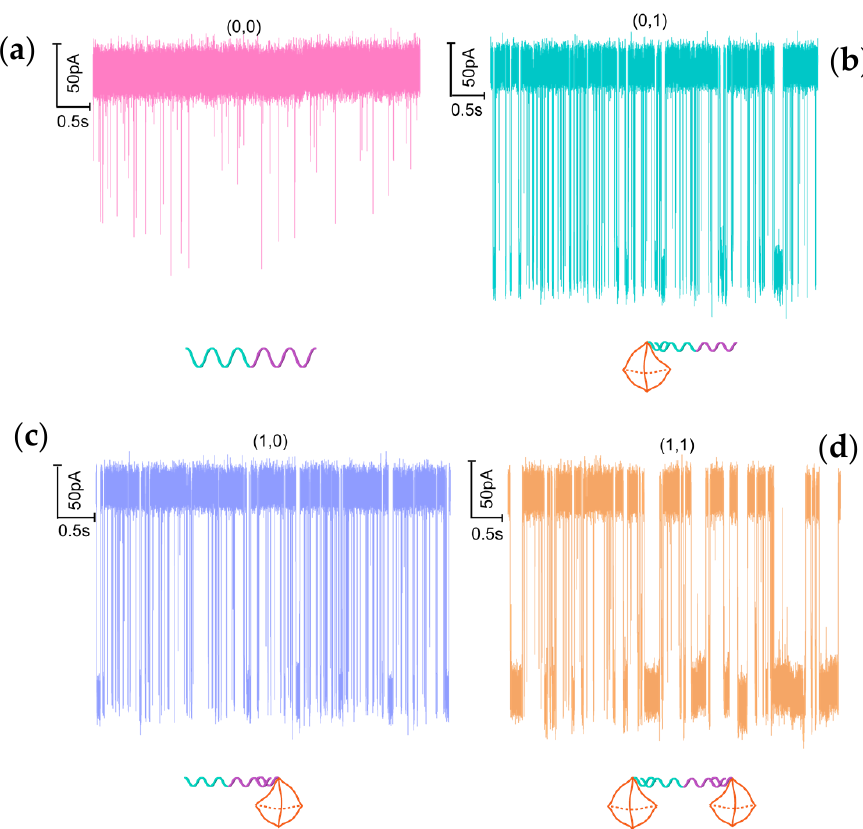
Figure 2. ( a – d ) Continuous current traces for different DNA logic operations (0, 0), (0, 1), (1, 0), (1, 1) translocation through a 3.5 nm diameter solid-state nanopore under 100 mV voltage in 1 M LiCl. The concentrations of tetrahedron Probe 1 and Probe 2 were 10 nM, respectively. The molar ratios of Probe 1/Probe 2/DNA(miR-21) are 0:0:1 in (0, 0), 0:1:1 in (0, 1), 1:0:1 in (1, 0), and 1:1:1 in (1, 1). Furthermore, the data from four DNA logic operations are analyzed. The mean ampli- tude of (0, 0), (0, 1), (1, 0), (1, 1) was 106.17 ± 0.95 pA, 205.82 ± 0.78 pA, 206.79 ± 0.99 pA, and 215.28 ± 0.55 pA, respectively, as shown in Figure 3. According to the results of the analysis, the presence of the tetrahedral probe increases the translocation amplitude and also increases the signal-to-noise ratio. It can be found that the amplitude of (1, 1) is slightly different from the amplitude of (0, 1) and (1, 0), however the amplitude of (0, 1) is almost the same as that of (1, 0). It is reasonable that the configuration is almost the same for Probe 1 and Probe 2 (T1 tetrahedral probe is composed of A7, B7-C1, C7, and D7, while T2 tetra- hedral probe is composed of A7, B7-C2, C7, and D7), the same tetrahedron with a single strand that is partially complementary to the DNA fragment (miR-21). The slight difference in amplitude between (0, 1), (1, 0) and (1, 1) might be caused by the almost uniform lateral occupation ratio of the molecular translocation through the nanopore. It means that the double tetrahedron structure has no advantage over the single tetrahedron in increasing the signal amplitude. Therefore, based on the analysis of amplitude alone, we cannot distinguish the three patterns of logic operation ((0, 1), (1, 0), and (1,